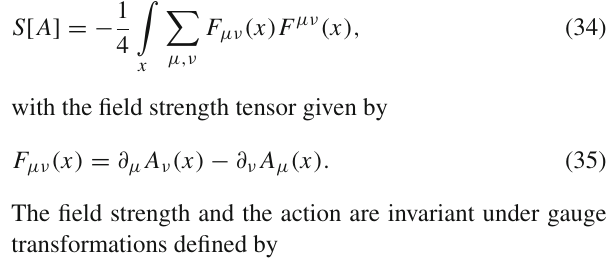
Fig. 1 This plot shows a comparison of three different numerical schemes for solving the wave equation in 2+1: (top) explicit leapfrog scheme (11), (middle) the implicit scheme (21), (bottom) semi-implicit scheme (24) with “magic time-step” a 0 = a 1 . The horizontal axis is the x 1 coordinate; the vertical axis is the field amplitude φ x in arbitrary units.The x 2 coordinateissuppressed.Theinitialcondition(seenonthe left) is a Gaussian pulse which propagates to the right under time evo- lution. Due to numerical dispersion of the leapfrog and implicit scheme the original shape of the Gaussian is lost over time. On the other hand, the dispersion-free semi-implicit solver conserves the original pulse